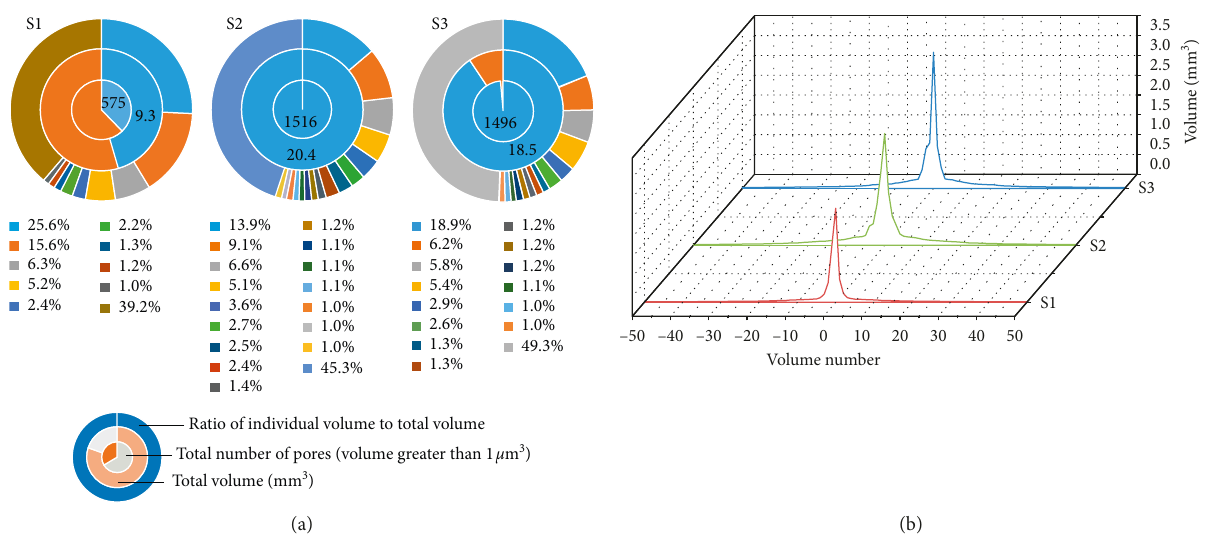
Figure 9: Distribution of pore volumes: (a) volume and number of pores and (b) unimodal distribution of